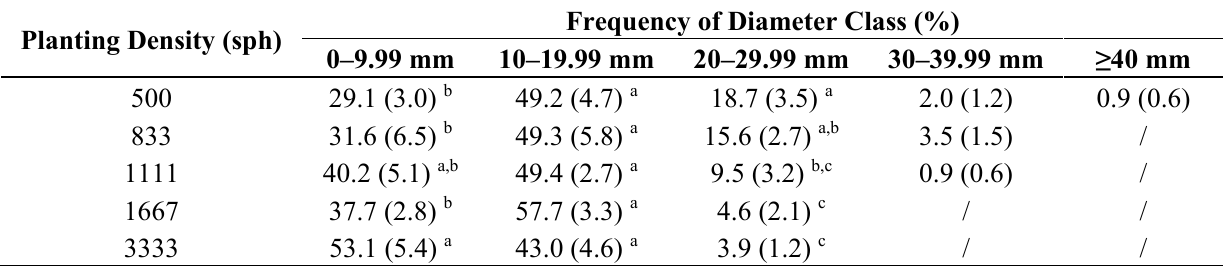
Table 5. Frequency distribution of occluded branch diameter of Betula alnoides . Planting Density (sph)